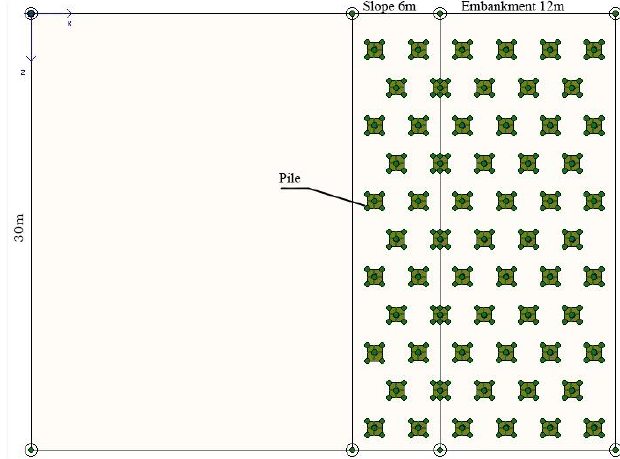
Figure 16. Triangle net arrangement of piles in GRPSE system.